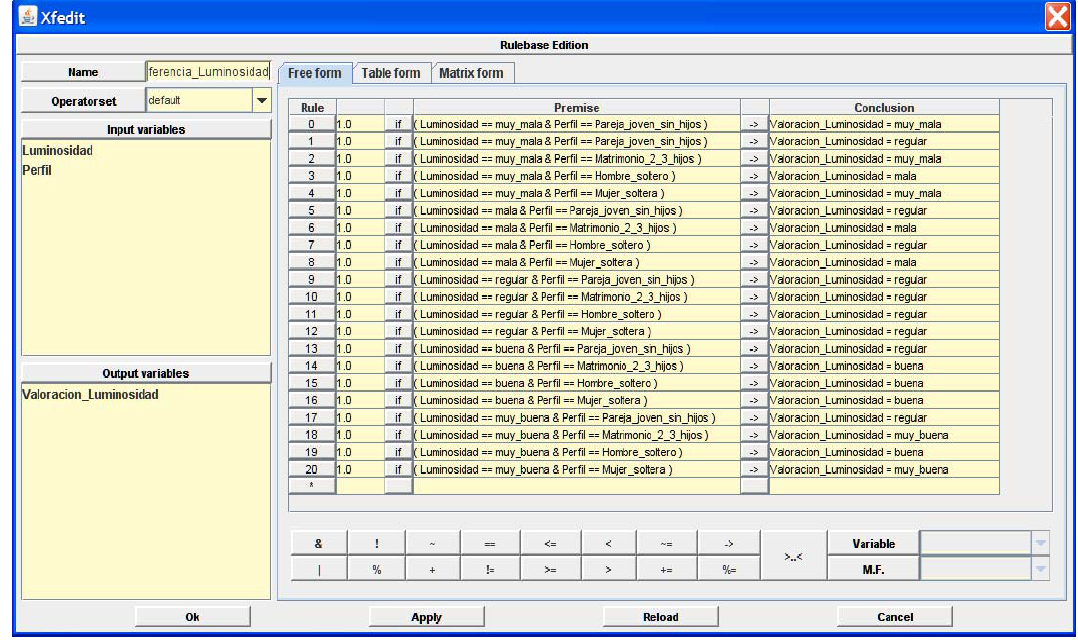
Fig. 10: Fuzzy inference rules in Xfuzzy